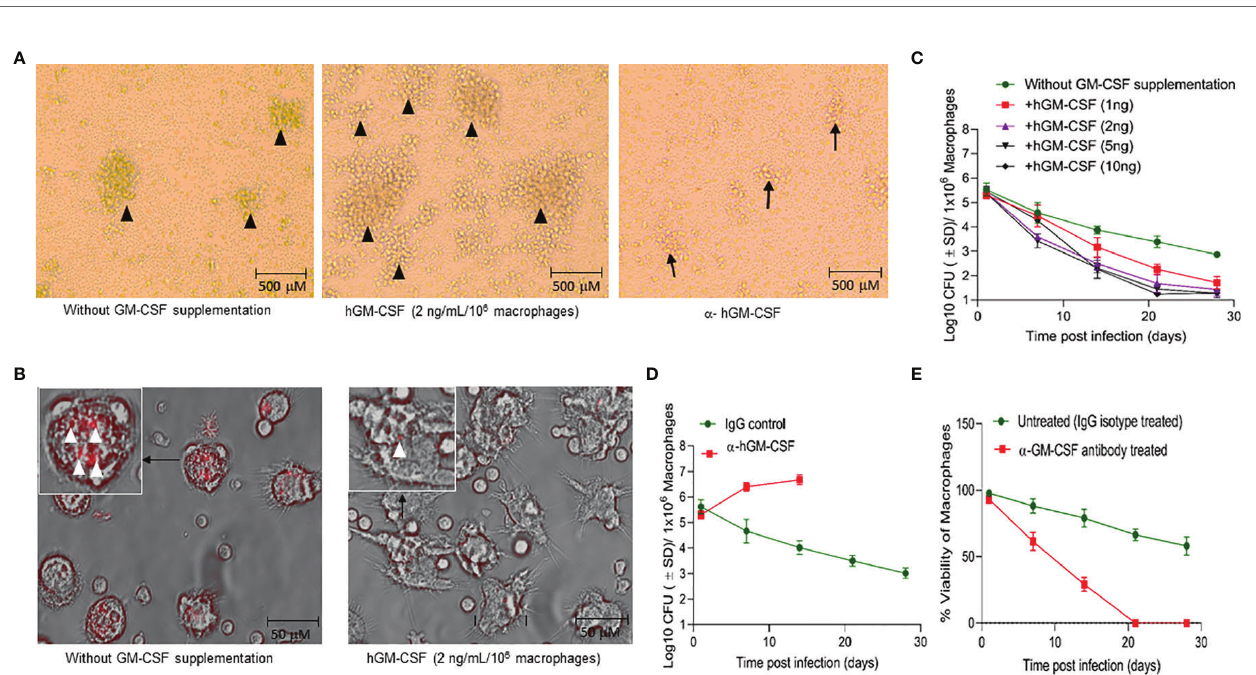
FIGURE 3 | GM-CSF induces formation of granulomatous structures and differentiation of macrophages to control bacterial burden and host cell survival during M. tuberculosis infection. (A) In vitro granuloma-like structure formation in untreated, hGM-CSF (2 ng/10 6 macrophages), a -hGM-CSF (2 m g/10 6 macrophages) treated macrophages. Macrophages were infected with M. tuberculosis (H37Rv; MOI 1:1) resulting in the formation of granulomas by day 7 post-infection. Images were acquired at 4x magni fi cation with an inverted bright fi eld microscope using macrophages of a single random healthy donor. (B) At day 14 post-infection with